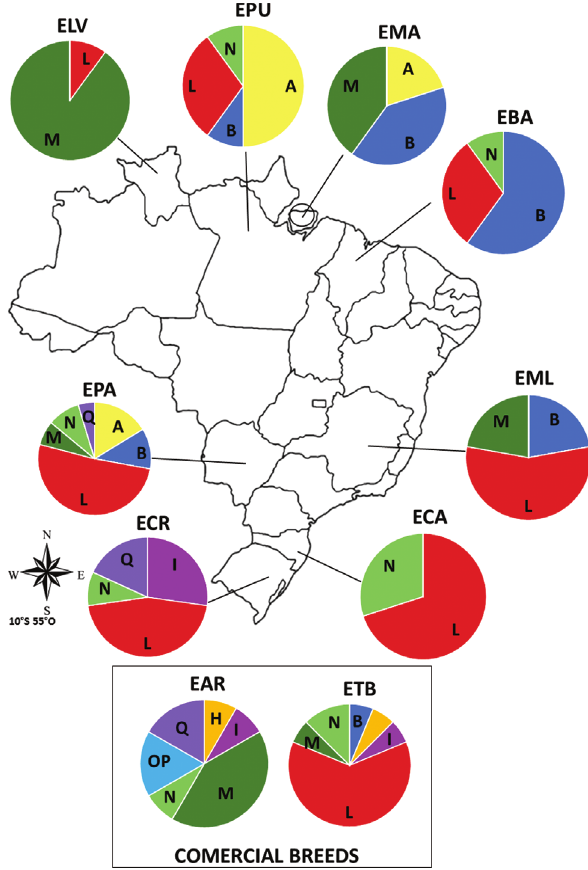
Figure 1 - Haplogroup frequency in Brazilian horse breeds. Haplogroup classification is according to Achilli et al. (2012). Horse Breeds: ELV - Lavradeira; EPU - Puruca; EMA - Marajoara; EBA - Baixadeira; EPA - Pantaneira; ECR - Crioula; EML - Manga Larga; ECA - Campeira; EAR - Árabe; ETB - English